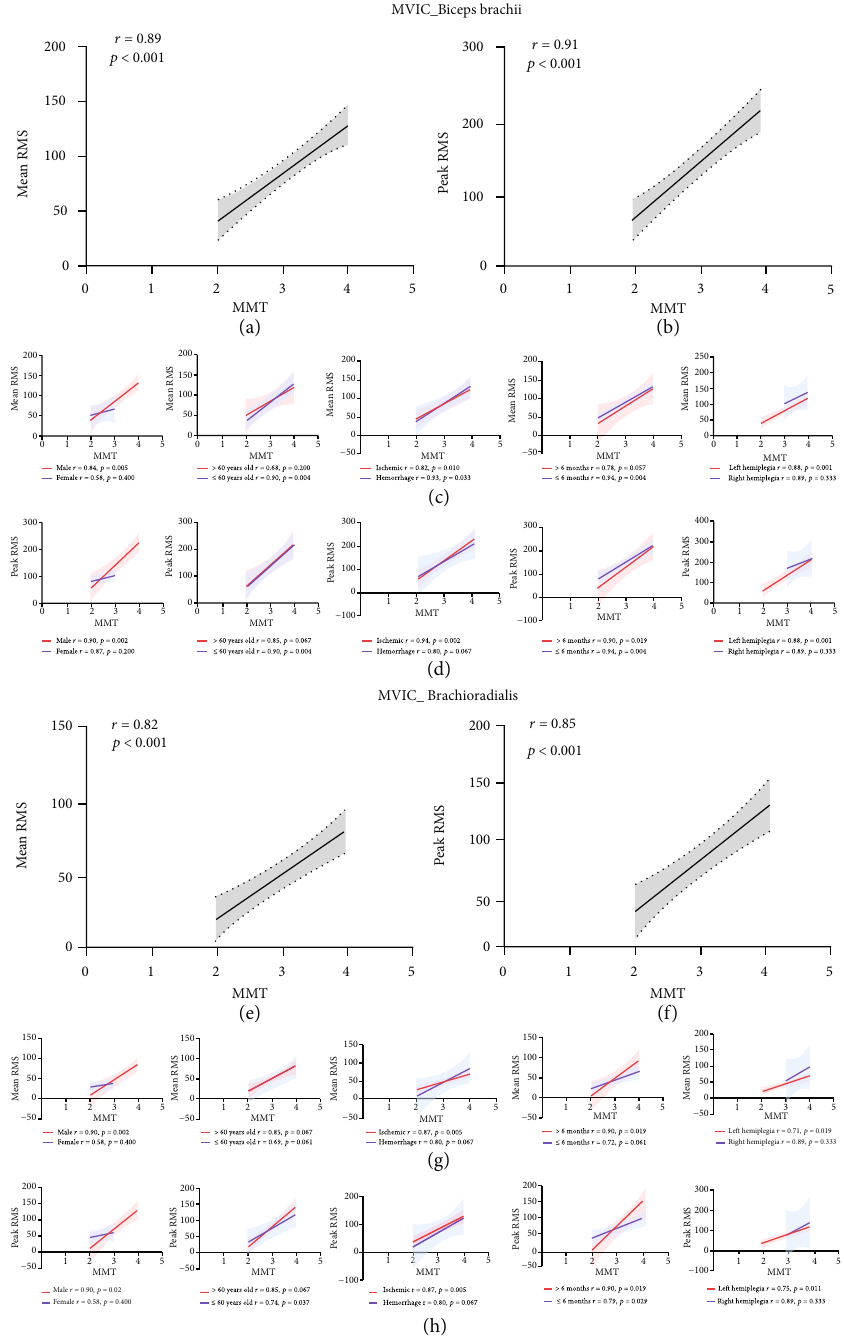
Figure 5: Correlation between sEMG values (mean and peak RMS values) and elbow fl exion (biceps brachii and brachioradialis) muscle strength during MVIC on the paretic side. (a) Correlation between MMT score and mean RMS values of the biceps brachii during MVIC. (b) Correlation between MMT score and peak RMS values of the biceps brachii during MVIC. (c) Correlation between MMT score and mean RMS values of the biceps brachii during MVIC in subgroups (sex, age, stroke type, poststroke duration, and hemiparetic side (left/right)). (d) Correlation between MMT score and peak RMS values of the biceps brachii during MVIC in the subgroups (sex, age, stroke type, poststroke duration, and hemiparetic side (left/right)). (e) Correlation between MMT score and mean RMS values of the brachioradialis during MVIC. (f) Correlation between MMT score and peak RMS values of the brachioradialis during MVIC. (g) Correlation between MMT score and mean RMS values of the brachioradialis during MVIC in subgroups (sex, age, stroke type, poststroke duration, and hemiparetic side (left/right)). (h) Correlation between MMT score and peak RMS values of the brachioradialis during MVIC in the subgroups (sex, age, stroke type, poststroke duration, and hemiparetic side (left/right)). sEMG: surface electromyography; MVIC: maximum voluntary isometric contraction; MMT: manual muscle test; RMS: root mean